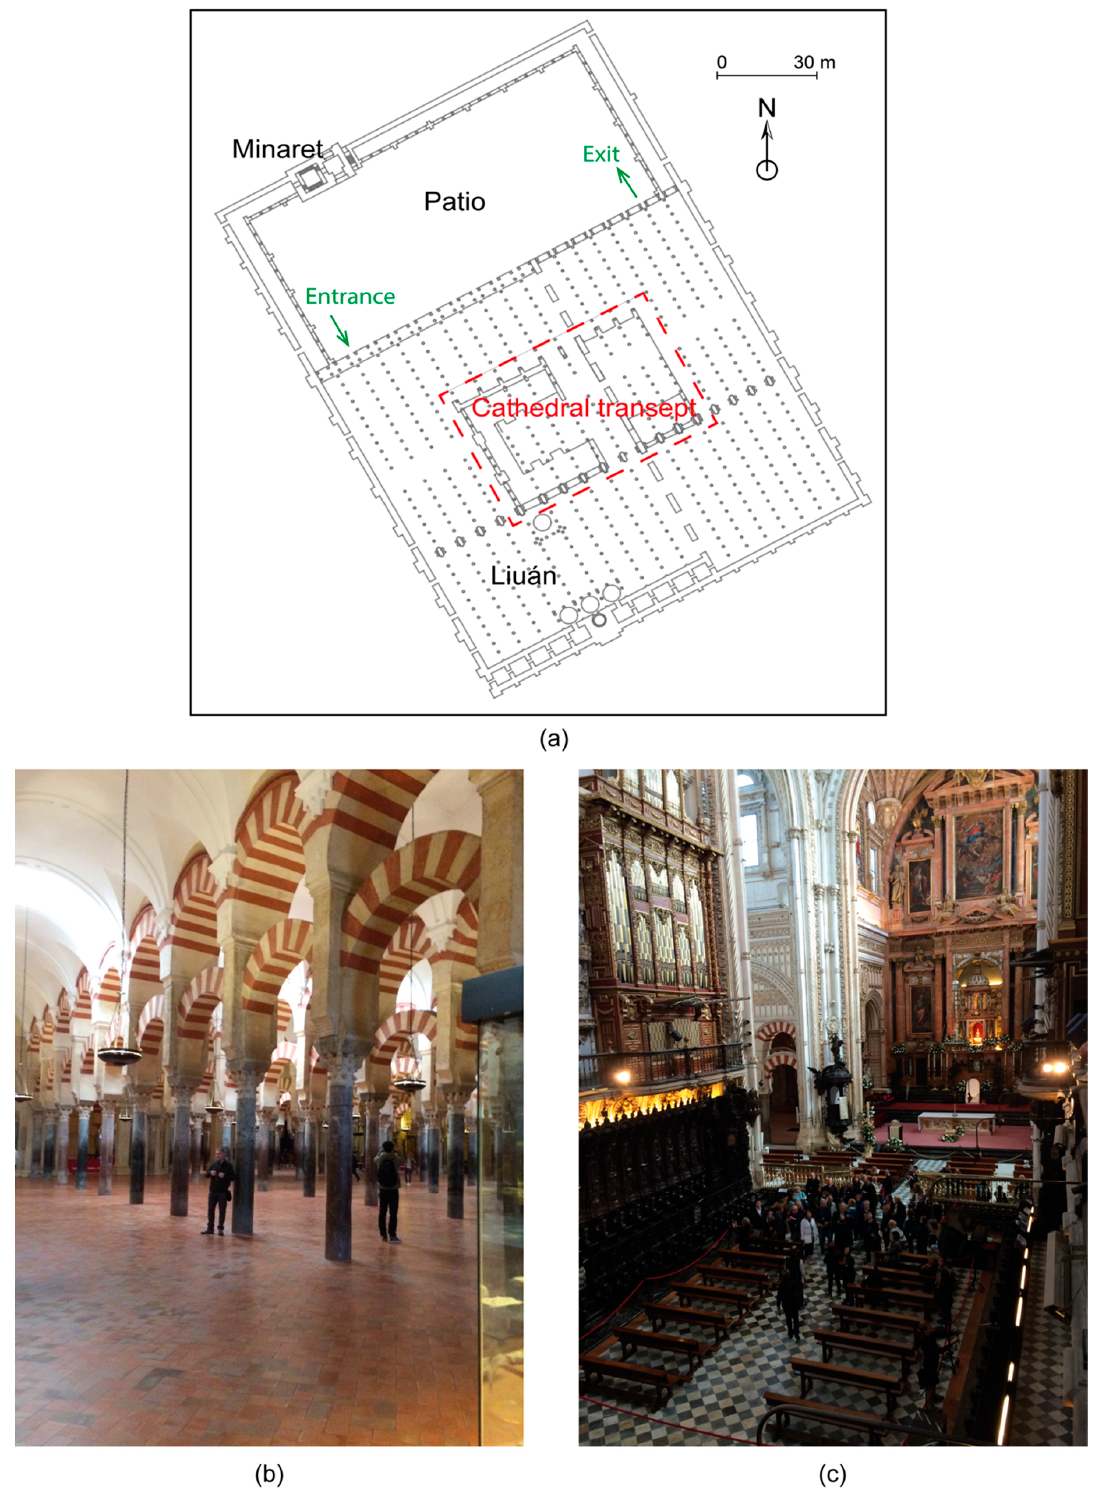
Figure 2. Details of Mosque-Cathedral: ( a ) key structural elements; ( b ) liuán; and ( c ) cathedral.